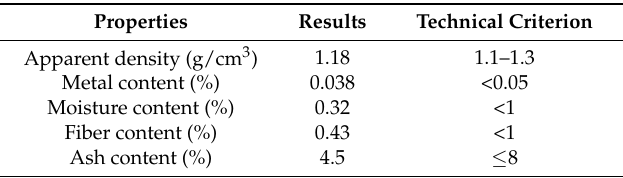
Table 2. Properties of crumb-rubber.